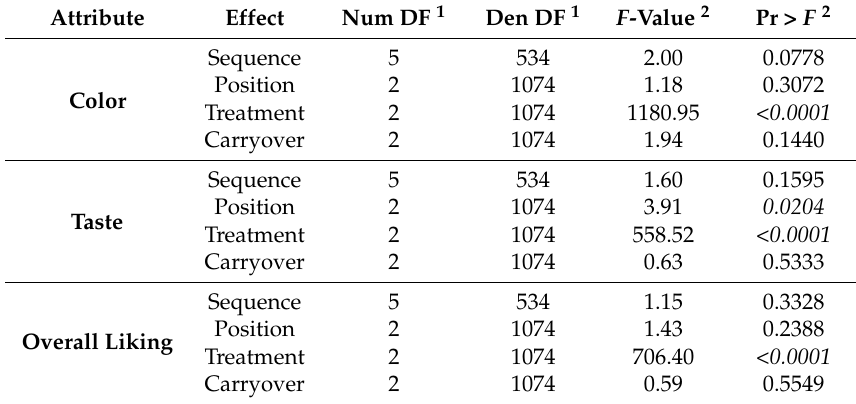
Table 3. Type I test of fixed effects evaluated on three attributes (color, taste, and overall liking) from model (1).